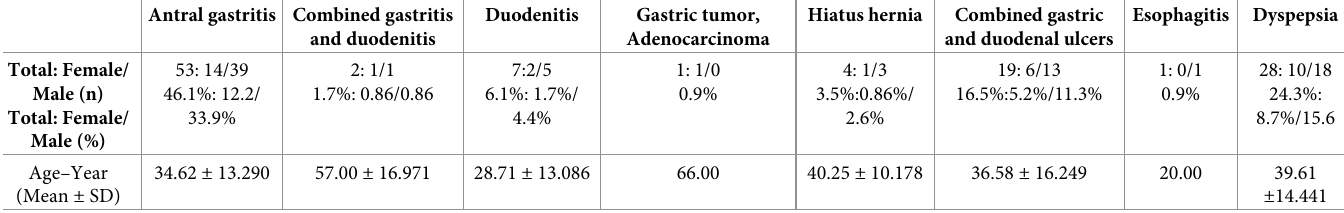
Table 1. The number of studied patients with gastrointestinal diseases symptoms subjected to endoscopy based on gender. Antral gastritis Combined gastritis Duodenitis Gastric tumor, Hiatus hernia Combined gastric Esophagitis and duodenitis Adenocarcinoma and duodenal ulcers